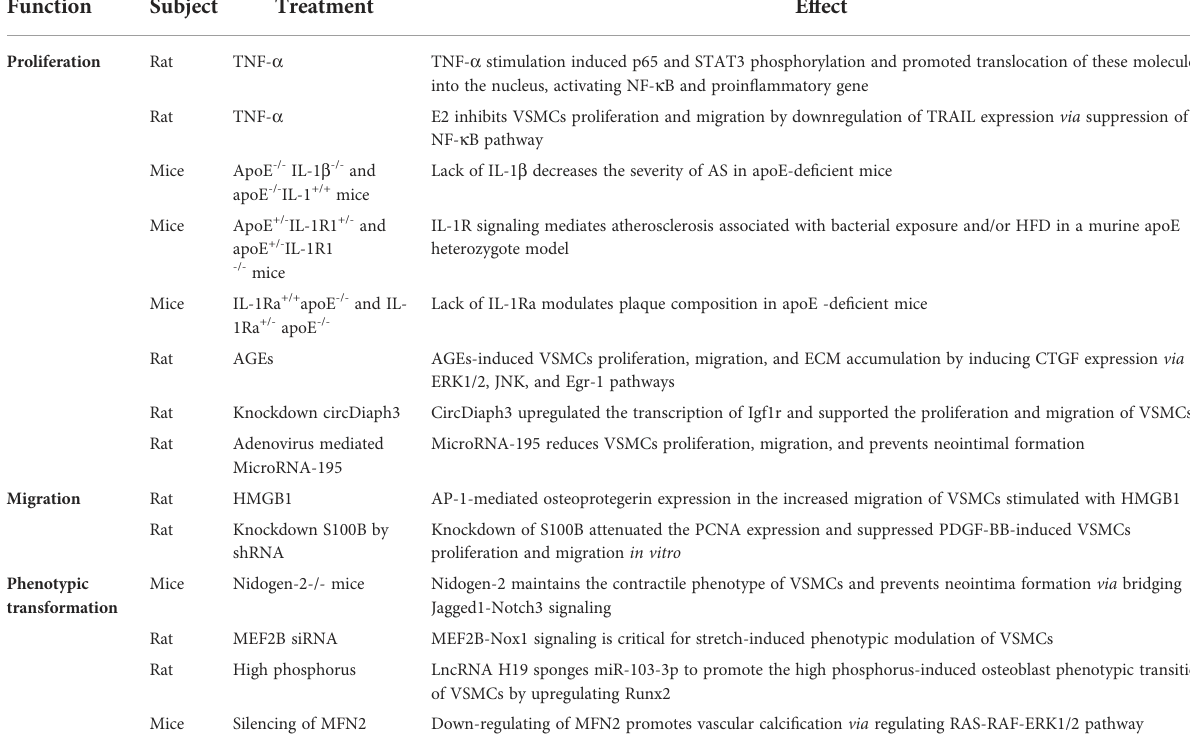
Table 2 Mechanisms of VSMCs in